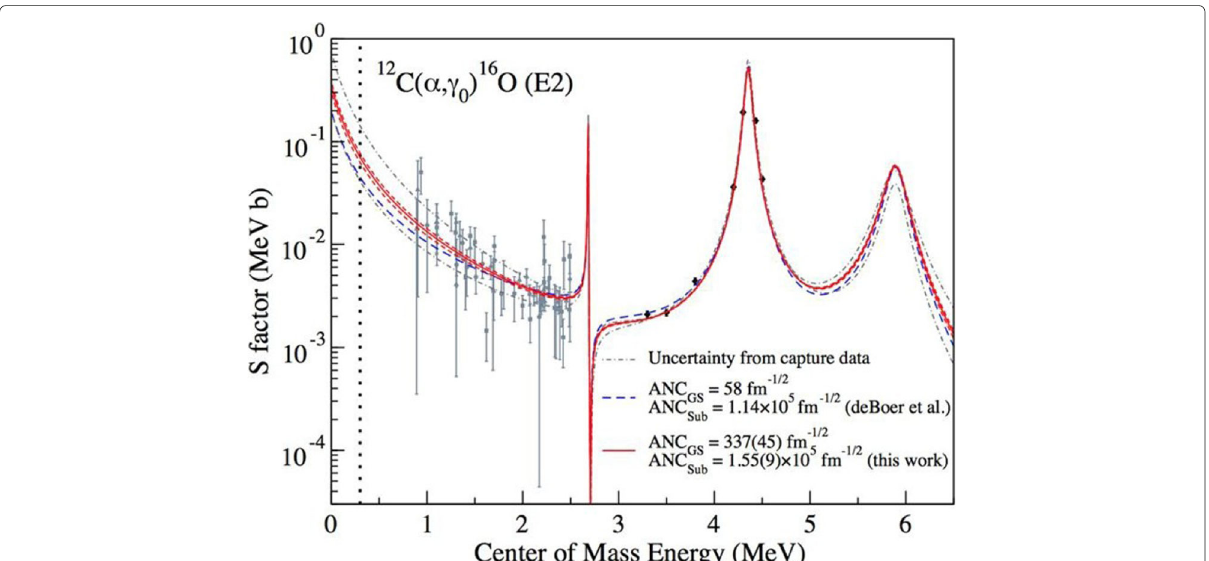
Fig. 3 The S E 2 (E) factor of the 12 C( α , γ ) 16 O reaction. The gray line represents the result constrained by the data of direct measurements. The red line represents the result determined with the ANC of 16 O ground state